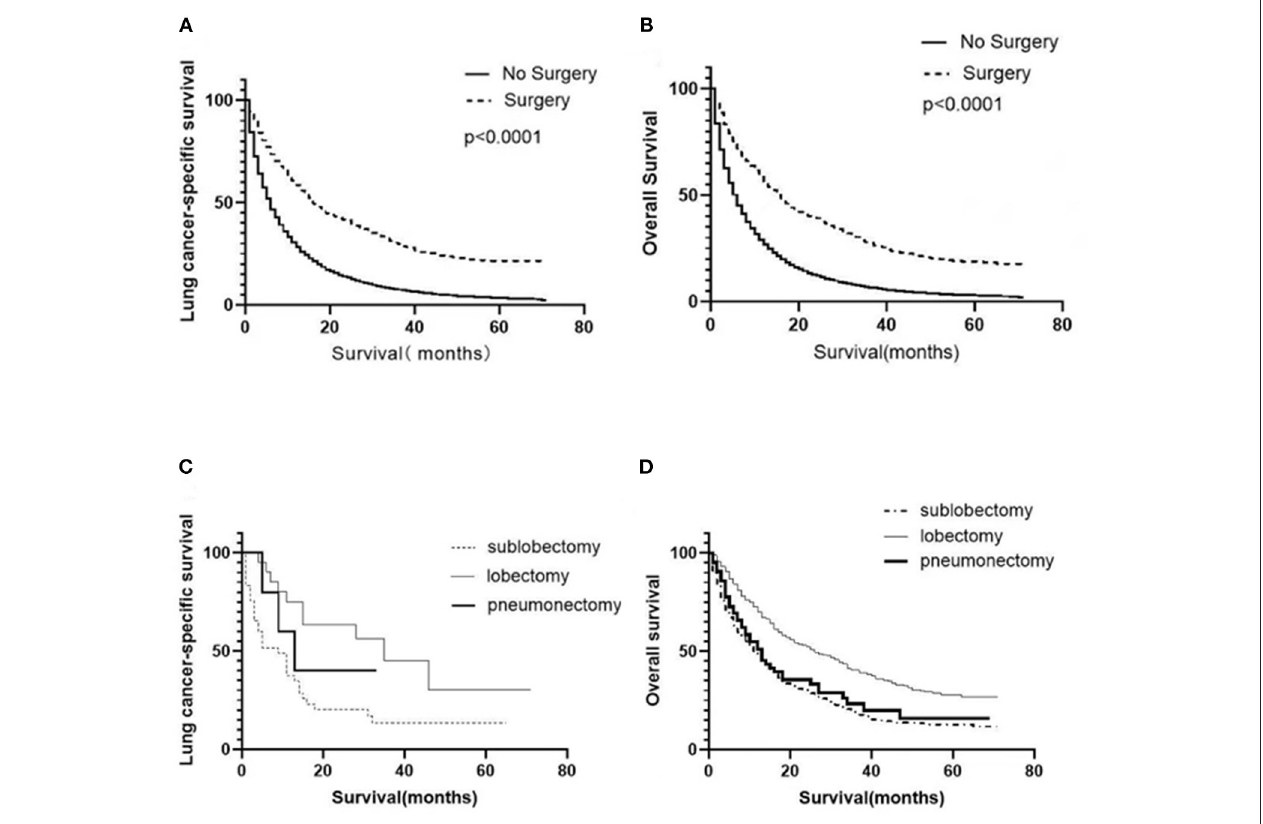
FIGURE 1 | Survival of NSCLC patients with metastasis. Survival curves showed the LCSS (A) and OS (B) of all patients in the surgery and non-surgery groups. Survival curves showed the LCSS (C) and OS (D) of surgical patients receiving different surgical